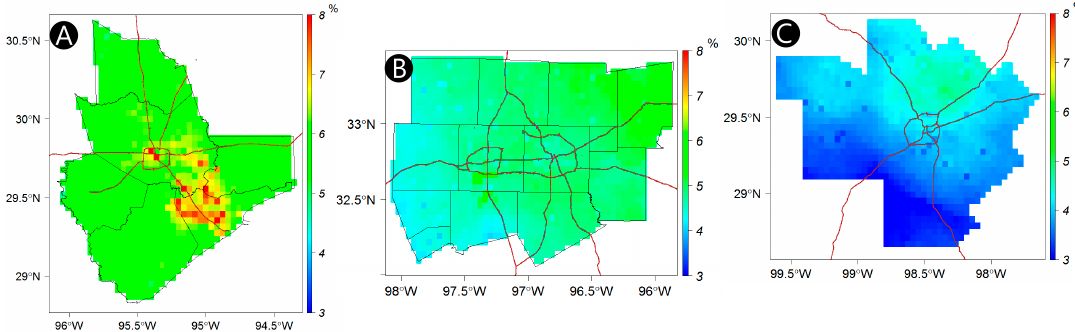
Figure 8. Spatial distribution of the average annual frequency of hourly precipitation for the major metropolitan areas in Texas ( A ) Houston; ( B ) Dallas–Fort Worth; ( C ) San Antonio–New